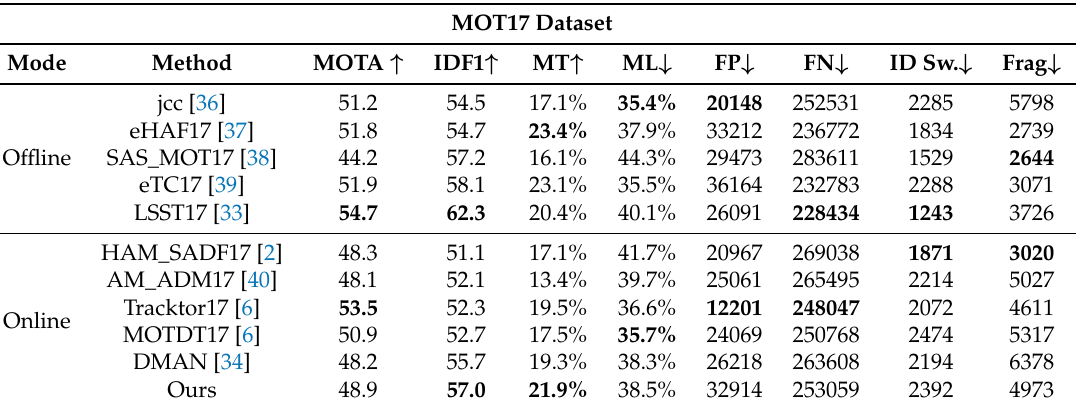
Table 1. Tracking performance on the MOT17 benchmark dataset. Best in bold. Definitions of abbreviations haven’t been introduced before: ML, FP, FN, ID Sw. and Frag. stand for Most Lost, False